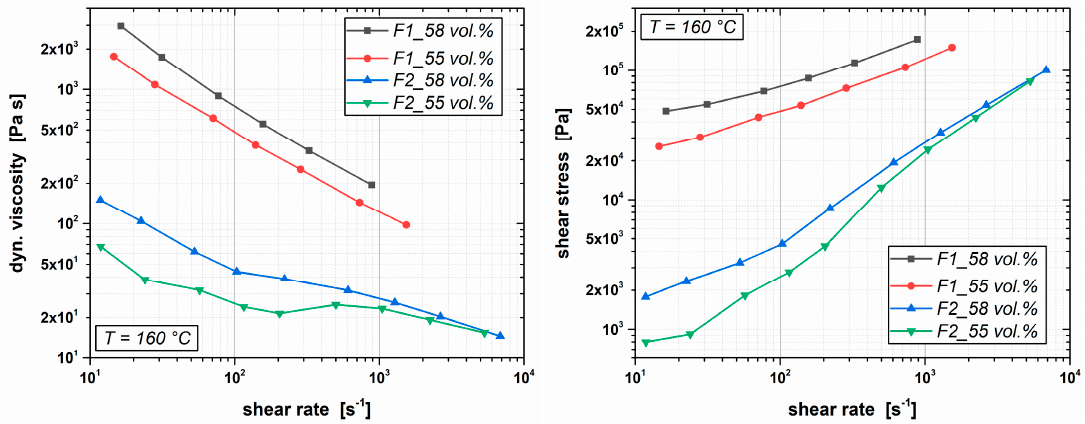
Figure 7. Rheological characterization of PVB-/PEG-based molding compounds with different quantities of the binder components (F1 and F2) for two different alumina powder filler degrees (55 and 58 vol.%) . Table 2. Viscosity at 160 °C (operating temperature) of alumina feedstocks with 55 or 58 vol.% powder loading based on binder systems containing 50 vol.% of the backbone polymer PVB (F1) or 50 vol.% of the lower molecular binder component PEG 4000 (F2).